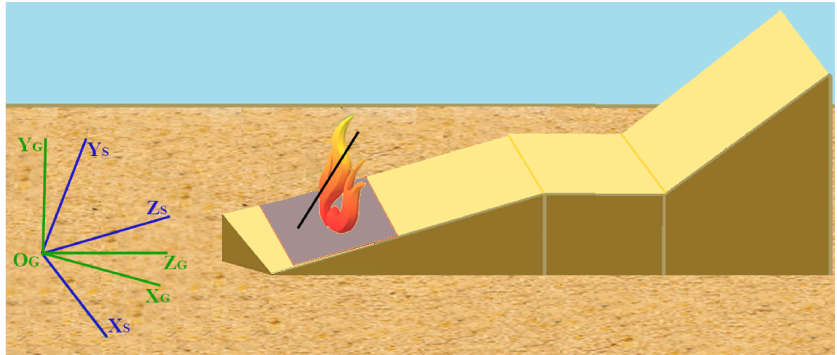
Figure 9. Slope frame (blue) and global frame (green). The black line represents the normal of the local.